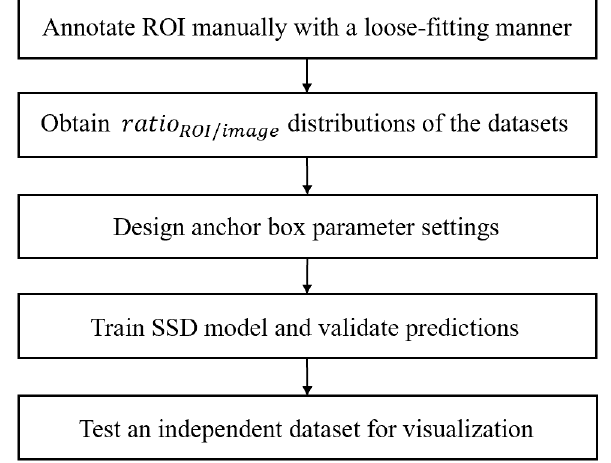
Figure 1. Overview of the proposed framework for hip ROI detection.